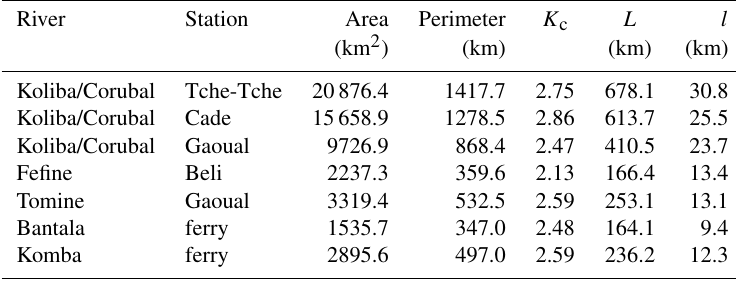
Table 1. Morphometric characteristics of the Basin and its sub-basins.